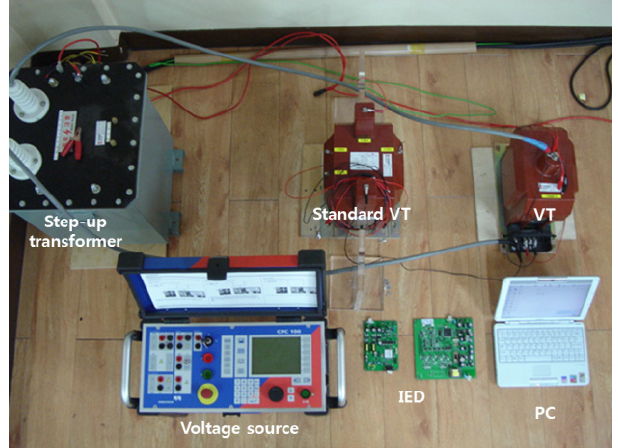
Figure 10. Configuration of the experimental test system.